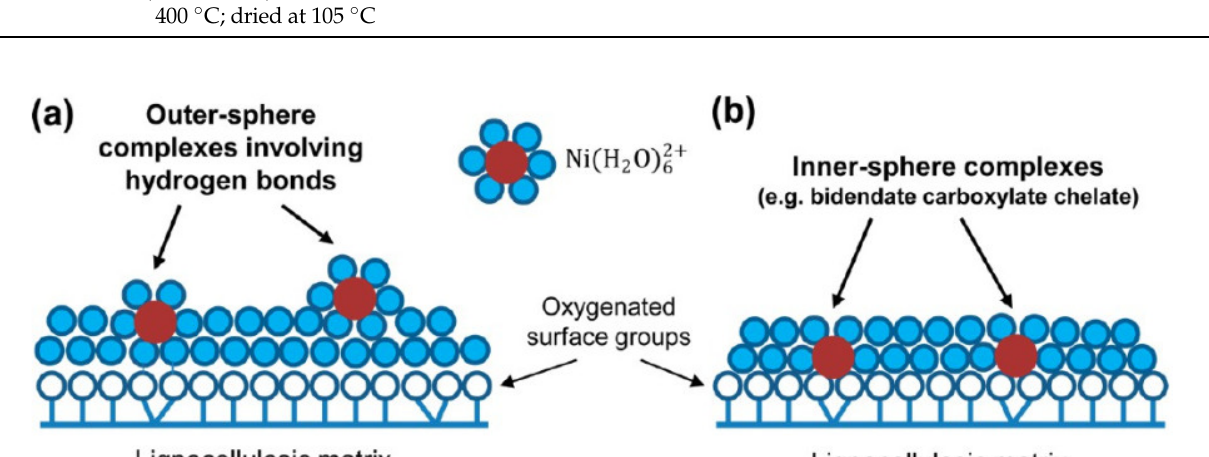
Figure 5. Effect of the impregnation method on Ni 2+ adsorption mechanisms; ( a ) atmospheric pressure impregnation and ( b ) vacuum impregnation [75]. Reprinted with permission from [75]. Copyright (2013) American Chemical Society.